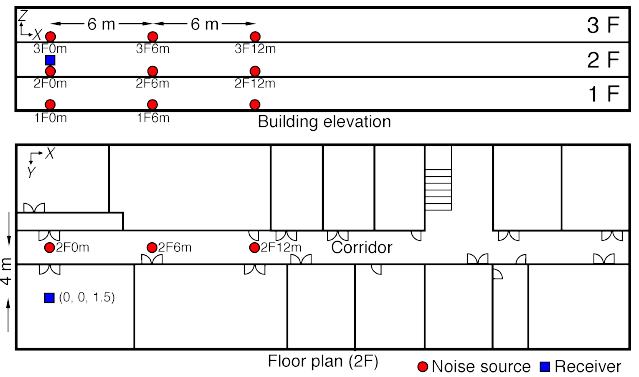
Figure 2. Noise sources and the receiver arrangement for inter-floor noise generation and recording